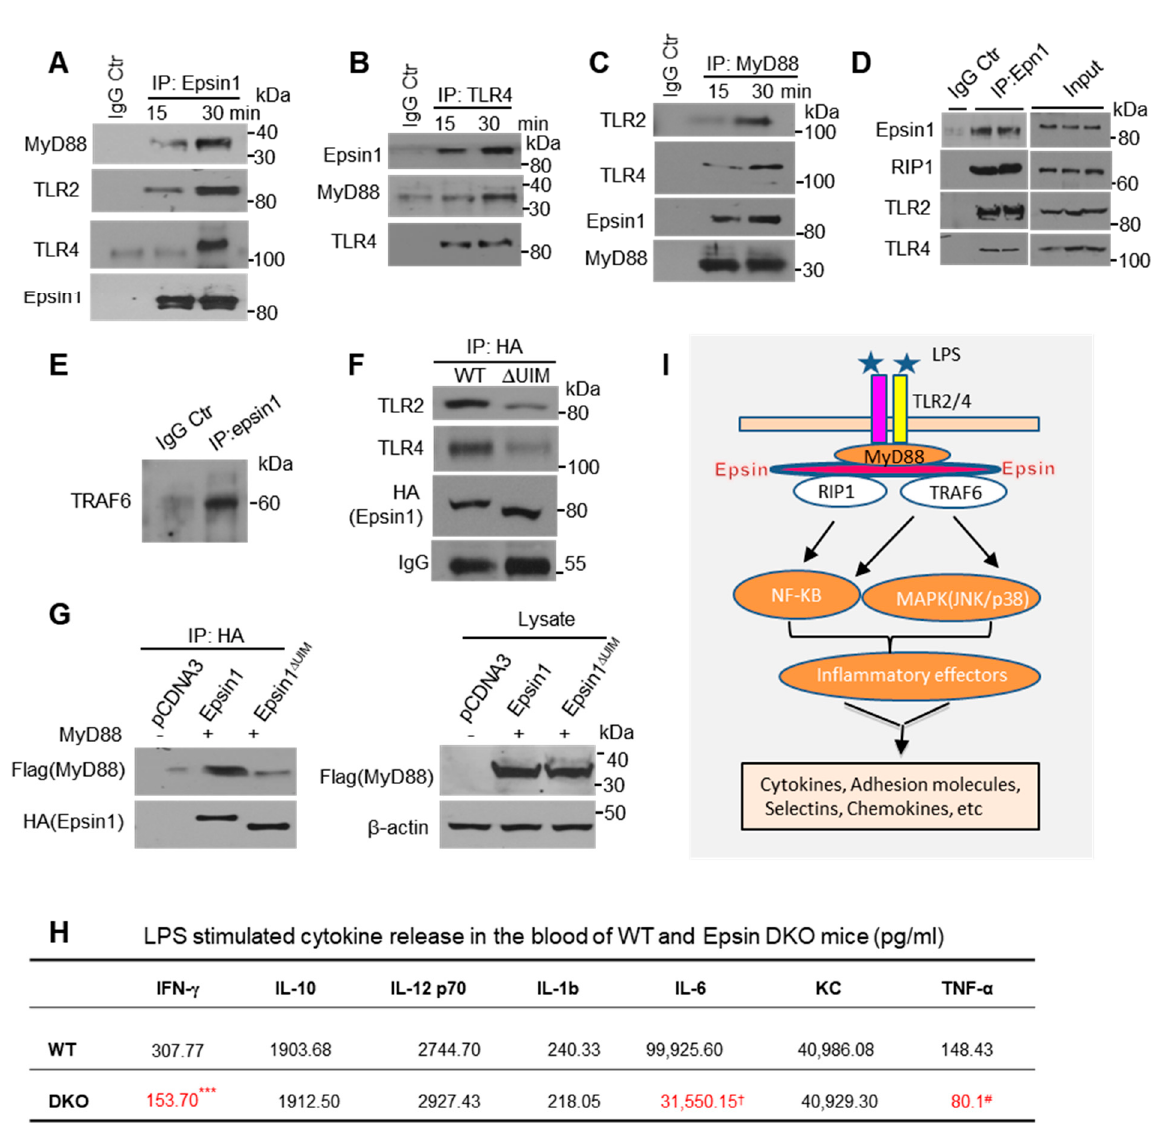
Figure 6. Epsins interact with the TLR2/4 signaling complex to exacerbate inflammation. ( A ) Wild type MAECs were treated with 100 ng/mL LPS for 15 or 30 min and lysates were used for IP with an epsin 1 antibody prior to Western blotting with MyD88, TLR2, and TLR4 antibodies (n = 5). ( B ) The same treatment as described above using a TLR4 antibody for IP and epsin 1, MyD88, and TLR2/4 antibodies for Western blotting (n = 5). ( C ) The same treatment as described above using MyD88 antibody for IP and blotted with epsin 1, TLR2, and TLR4 antibodies (n = 5). ( D ) LPS-treated MAECs (30 min) were used for IP with the epsin 1 antibody and blotting with RIP1, TLR2, and TLR4 antibodies (n = 5). ( E ) LPS-treated MAECs were used for IP with an epsin 1 antibody and blotted with a TRAF6 antibody (n = 5). ( F ) Epsin 1 wt (HA tag) or epsin 1 Δ UIM (HA tag) constructs were transfected to WT MAECs by electroporation. After 30 h, IP experiments using a HA antibody were performed and blotted using HA, TLR2, and TLR4 antibodies (n = 3). ( G ) Epsin 1 wt (HA tag) or epsin 1 Δ UIM (HA tag) were co-transfected to MAECs with MyD88 (Flag tag) by electroporation. After 30 h, cells were lysed and IP was performed with a HA antibody, followed by blotting with Flag or HA antibodies. ( H ) Cytokines between ApoE − / − and EC-iDKO/ApoE − / − mice stimulated by LPS (10 mg/kg, IP injection) after 4 h. Serum was collected and cytokines were measured by ELISA (RND Systems). ***, INF γ ; †, IL-6; #, TNF α ; WT vs . DKO mice; all p < 0.05. ( I ) Diagram showing how epsins modulate inflammatory signaling by potentiating NF- κ B and MAPK signaling.